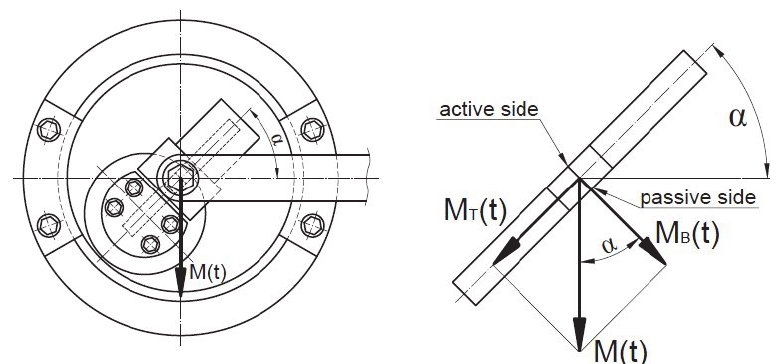
Figure 3: Loading of the specimen under proportional bending with torsion.